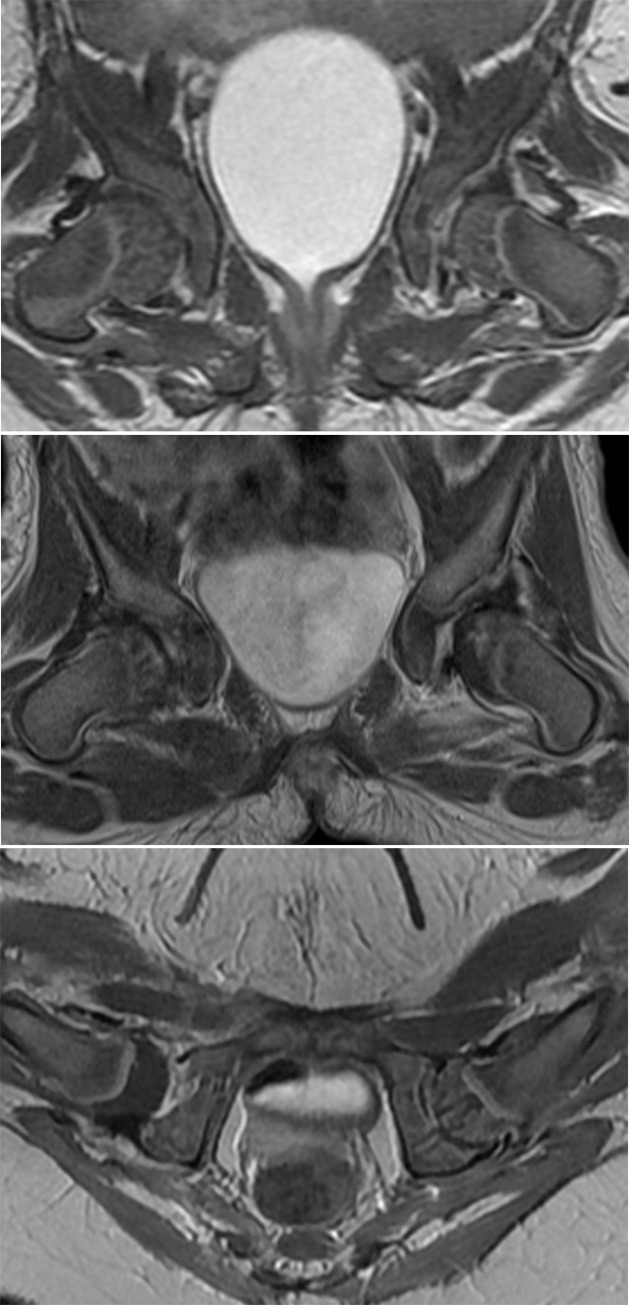
Pattern of contrast enhancement of the proximal femoral epiphysis.A. Contrast-enhanced coronal T1-weighted image in a 5-month old girl after closed reduction of the left hip shows a normal striated pattern of enhancement in the cartilaginous femoral epiphysis. B. Contrast-enhanced coronal T1-weighted image in a 4-month-old girl after closed reduction of the left hip shows a geographic area of decreased enhancement in the left femoral head. C. Contrast-enhanced axial T1-weighted image in a 7-month-old girl after closed reduction of the right hip shows a global decreased enhancement of the right femoral head.